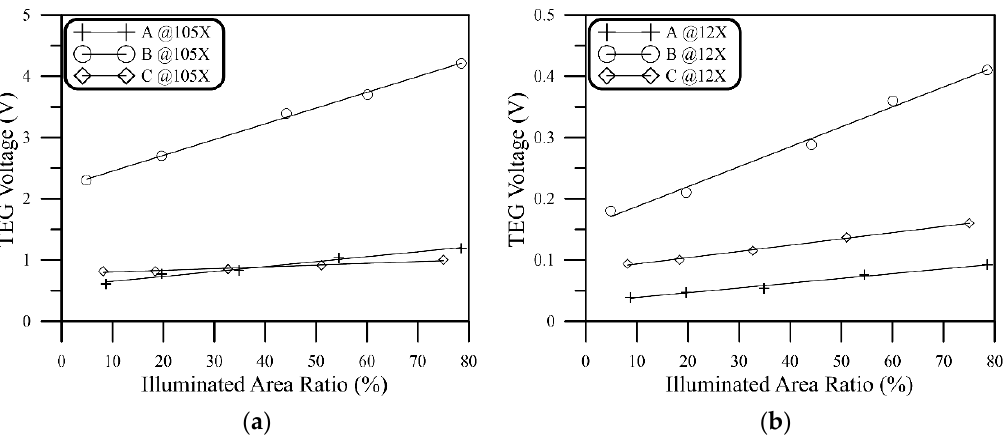
Figure 3. TEG output voltage of the three samples, A (3-cm TEG), B (4-cm TEG), and C (6.2-cm TEG),